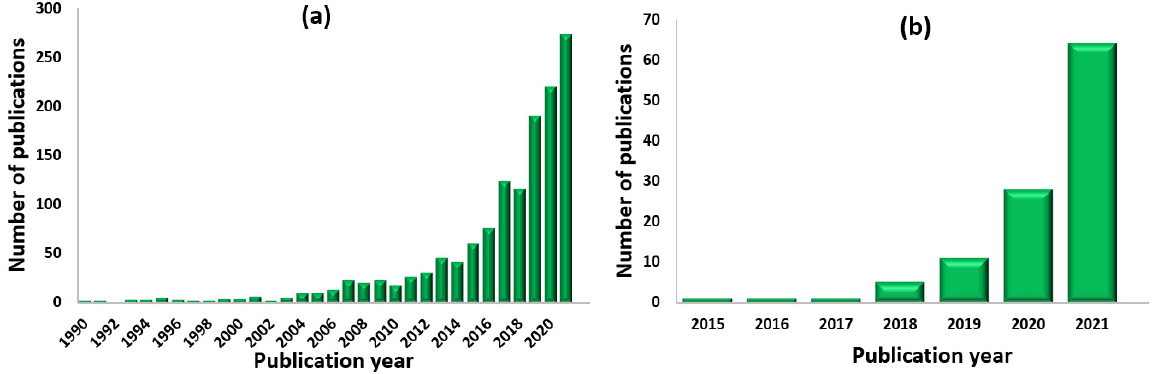
Figure 1. The number of publications in the area of 2D-materials-based gas sensors: ( a ) from 1990 to 2021, keyword for search: 2D gas sensors; ( b ) from 2015 to 2021, keyword for search: MXene gas sensors. Internet search of the Scopus on 17 January 2022.